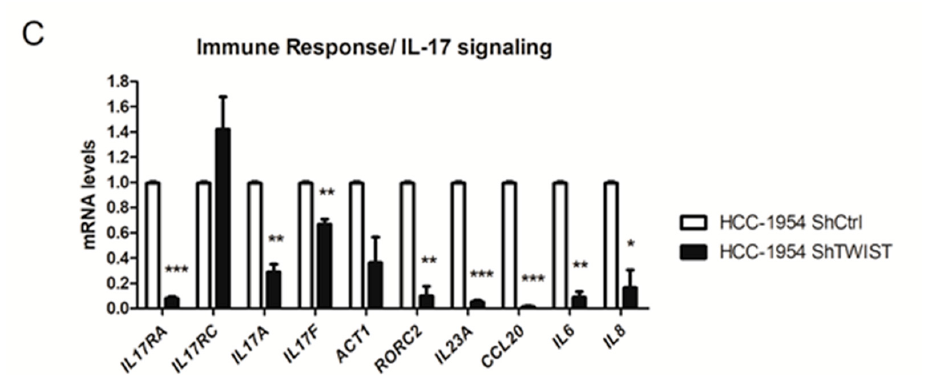
Figure 4. RT-qPCR of the genes altered in the best represented biological processes: ( A ) epithelial-mesenchymal transition (EMT)/Cell adhesion, ( B ) extracellular matrix (ECM) remodeling/Blood coagulation, and ( C ) immune response/IL-17 signaling. ShCTRL = negative silencing control; ShTWIST = TWIST1-knockdown. Data are shown as the mean (±SD). * p < 0.05; ** p < 0.01; *** p < 0.001.